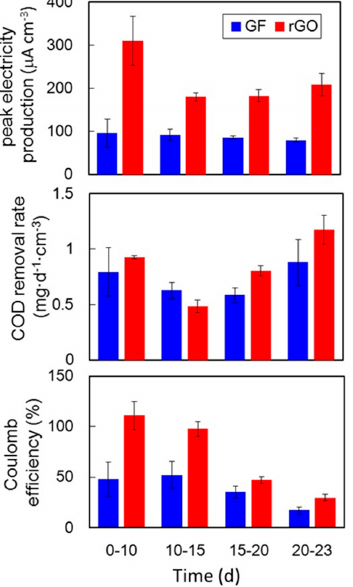
Figure 3. COD Cr removal and energy recovery efficiency in the rGO and GF complexes. The data shown represent the average values of three independent experiments, performed in parallel. The error bars are standard errors of the three determinations